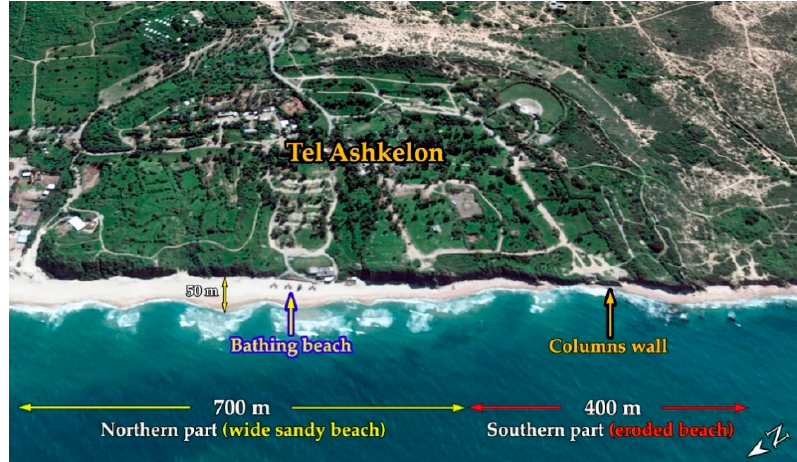
Figure 2. Tel Ashkelon and its coast, showing the eroded beach (0–15 m wide) (between the red arrows) at the vicinity of the Columns wall, and the wider (30–50 m) sandy beach (between the yellow arrows) at the vicinity of the bathing beach (Photo: A rotated Google Earth image, 28 January 2016).